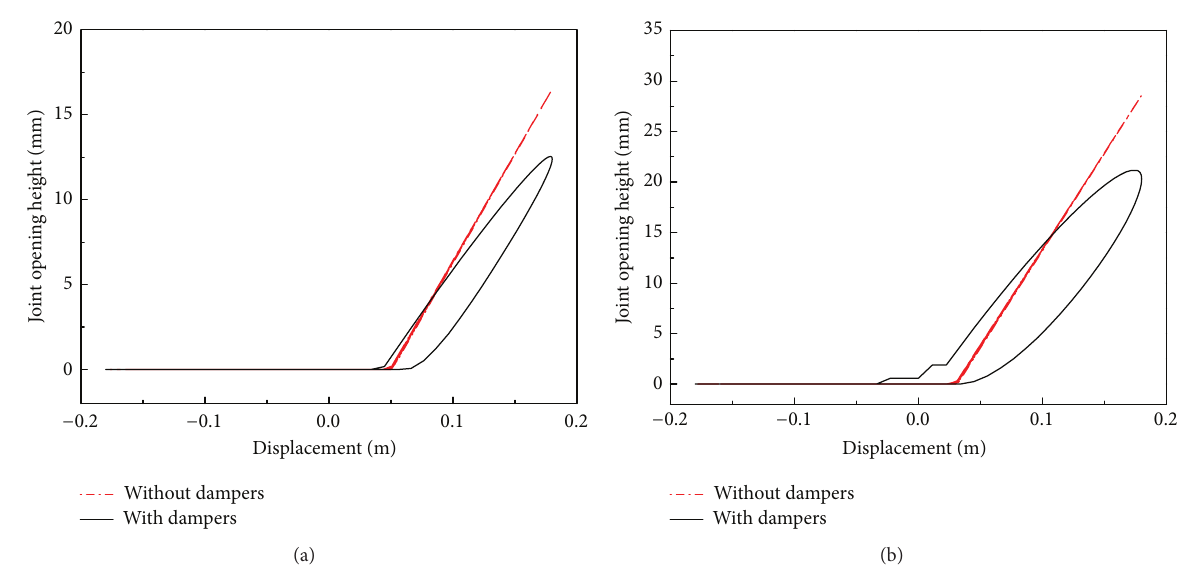
Figure 6: Gap opening height at the left side joint versus lateral top displacement of the pier: (a) longitudinal direction; (b) transverse